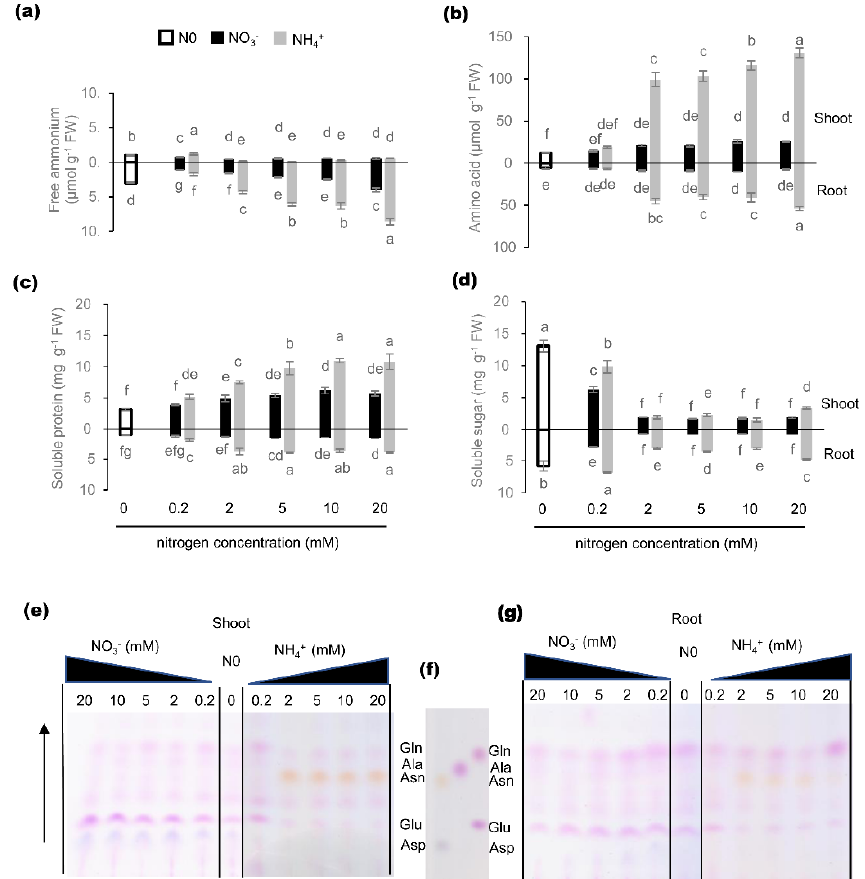
Figure 5. Carbon and nitrogen metabolite levels in response to different nitrogen regimes in shoot and root tissue. ( a ) ammonium, ( b ) free amino acid, ( c ) soluble protein, and ( d ) soluble sugar were determined. Individual amino acid components in response to different nitrogen regimes in shoot and root tissue. Amino acid components were analyzed with thin layer chromatography (TLC) and ninhydrin dye in ( e ) shoot and ( g ) root. ( f ) separation results of five amino acids (Gln, alanine (Ala), asparagine (Asn), Glu, and aspartate (Asp)) under the same conditions; 1.5 μ g of free amino acid extracted from shoot and root tissues were loaded onto each lane of the TLC. Data are means of three independent biological replicates ± SD. Letters above samples indicate statistically significant differences where p < 0.05 according to one-way ANOVA Duncan post-hoc test.